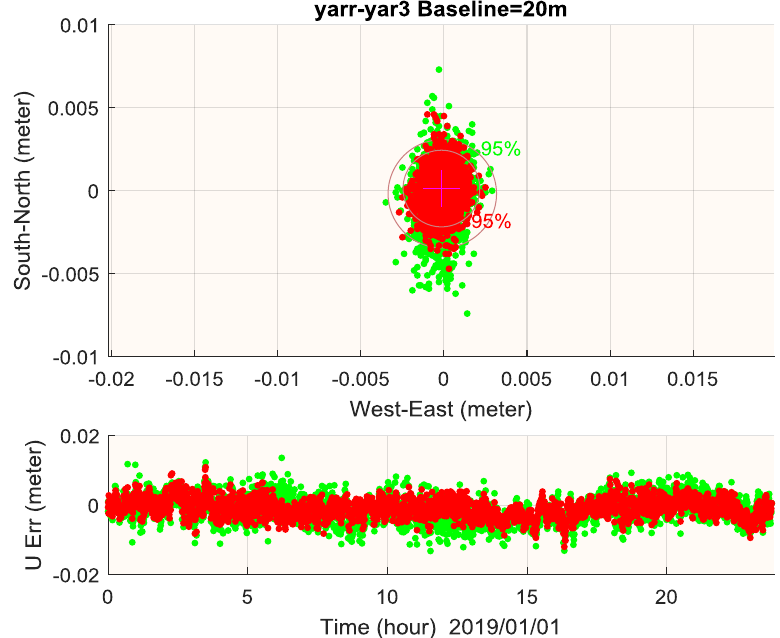
Figure 15. Twenty m baseline RTK performance in horizontal (upper) and vertical (lower) using BDS-2-only (green) and BDS-2+BDS-3 (red). The gray circle shows the 95% confidence level of horizontal error. Ambiguity fix percentage is 100% for both cases.